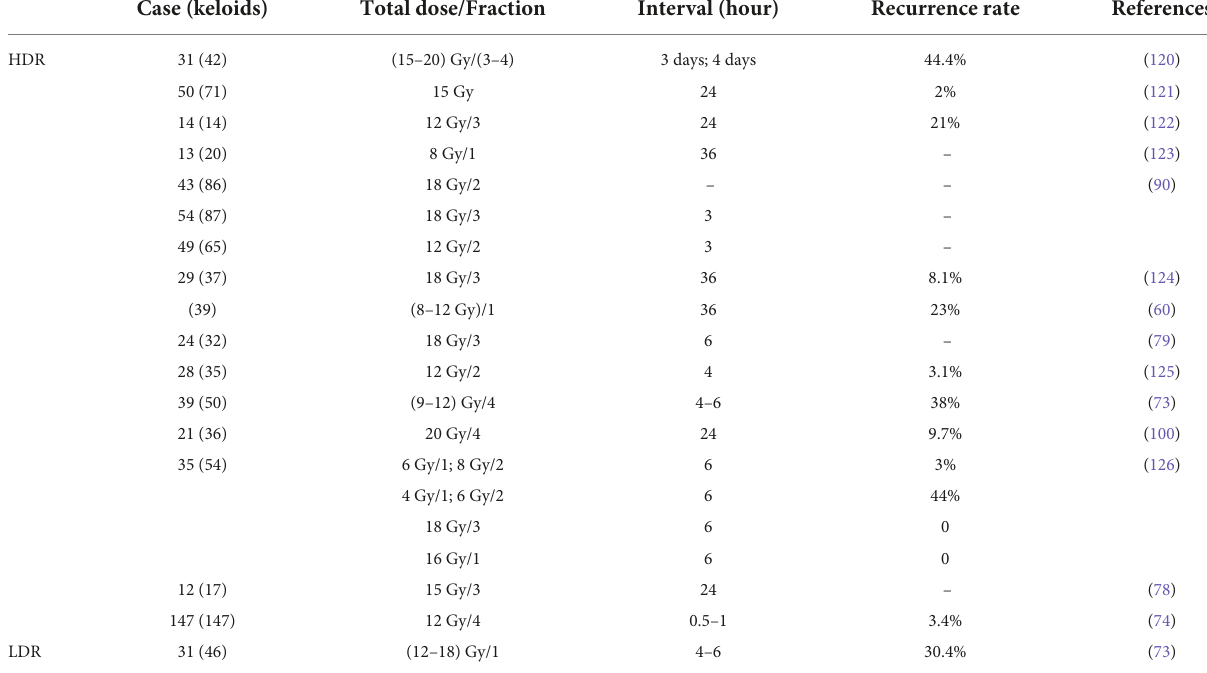
TABLE 3 Dose fractionation and recurrence rate of brachytherapy for keloids.